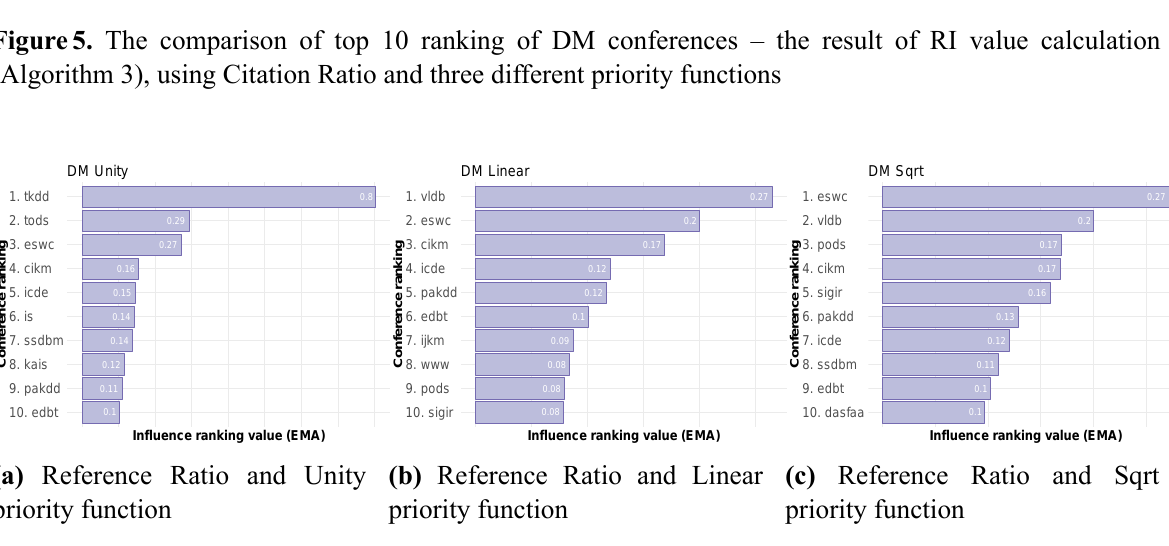
Figure 6. The comparison of top 10 ranking of DM conferences – the result of RI value calculation (Algorithm 3), using Reference Ratio and three different priority